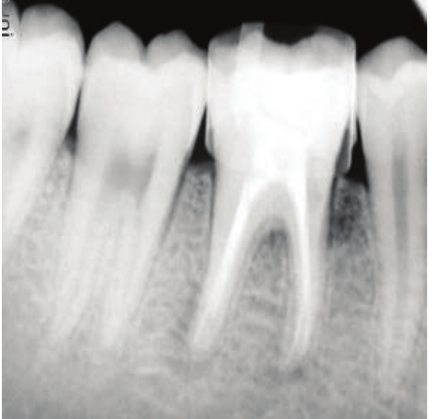
Figure 23: Radiograph showing luted inlay with respect to 37.